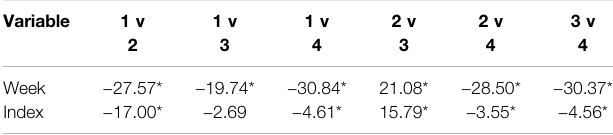
TABLE 2 | t -statistics for comparisons of mixed effects parameter estimates between pairs of latent classes. Variable